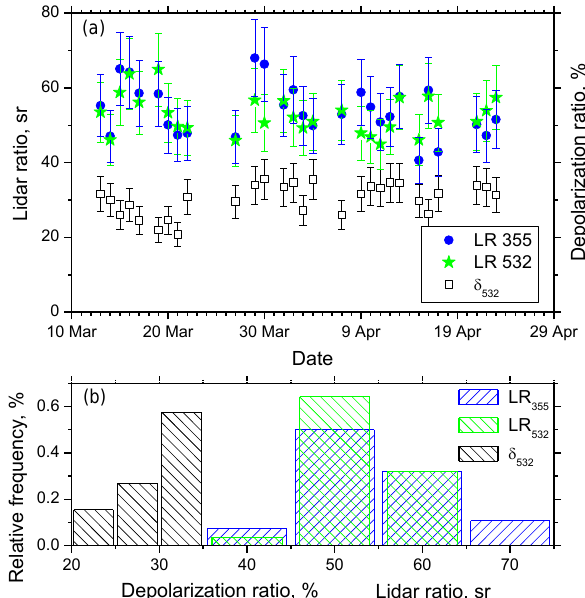
Figure 8. (a) Lidar ratios at 355 and 532nm together with parti- cle depolarization ratios at 532nm derived from lidar measurements within the 1500–2000m layer for the period of March–April 2015. (b) Frequency distribution of lidar and depolarization ratios.